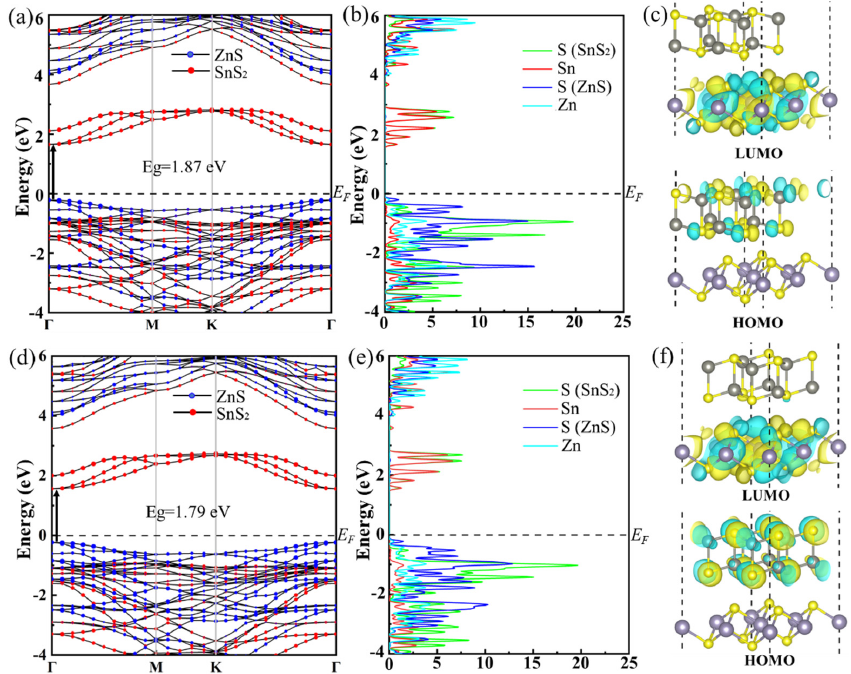
Figure 5. Projected band structure (obtained with the HSE06 function) of H3 ( a ) and H4 ( d ) hetero- junction; the blue and red symbols represent the contribution of ZnS and SnS 2 , respectively; the zero energy corresponds to the Fermi level and is represented by the black dashed line. The projected density of states of H3 ( b ) and H4 ( e ) heterojunction. The band decomposed charge density for HOMO (VBM) and LUMO (CBM) of the H3 ( c ) and H4 ( f ) heterojunction, and the value of the isosurface was set to 3 × 10 − 8 e.